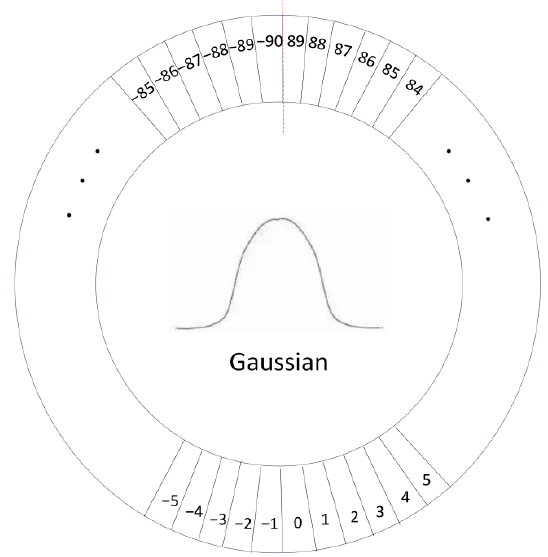
Figure 9. Circle smooth label